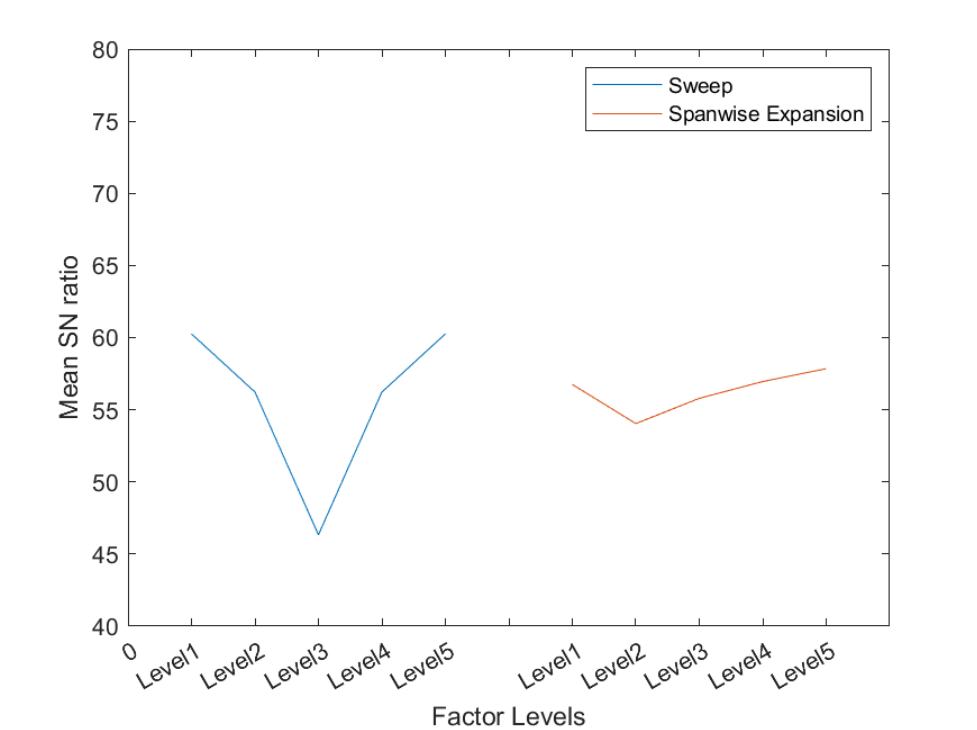
Figure 19. SN ratio for the second natural frequency of the morphed